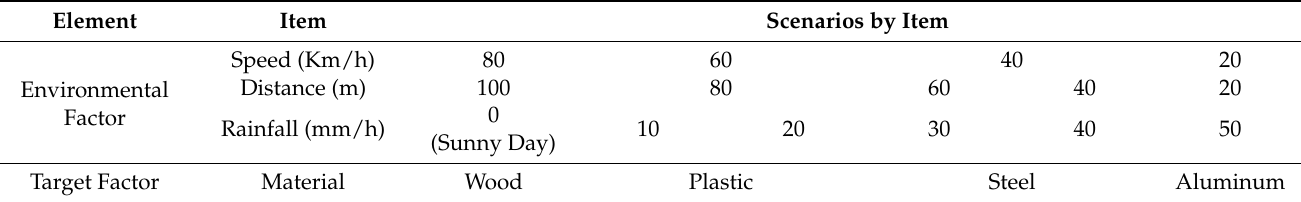
Table 3. Classification of test scenarios.